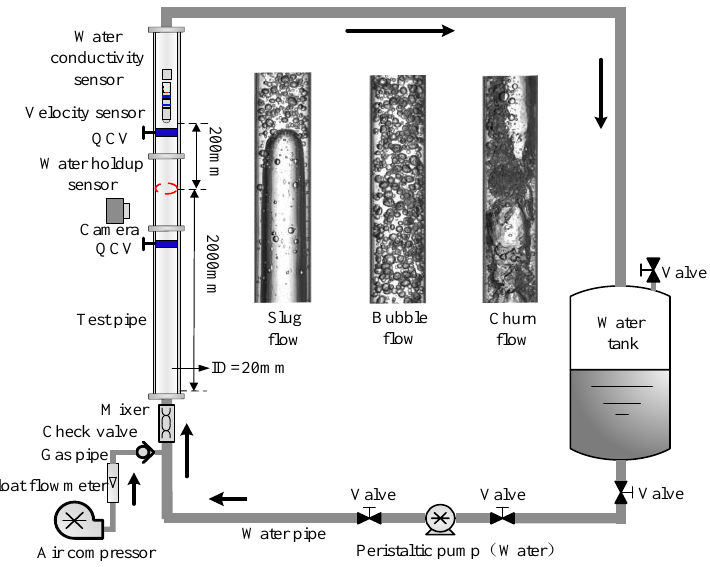
Figure 4. A schematic diagram of the experimental flow loop facility.